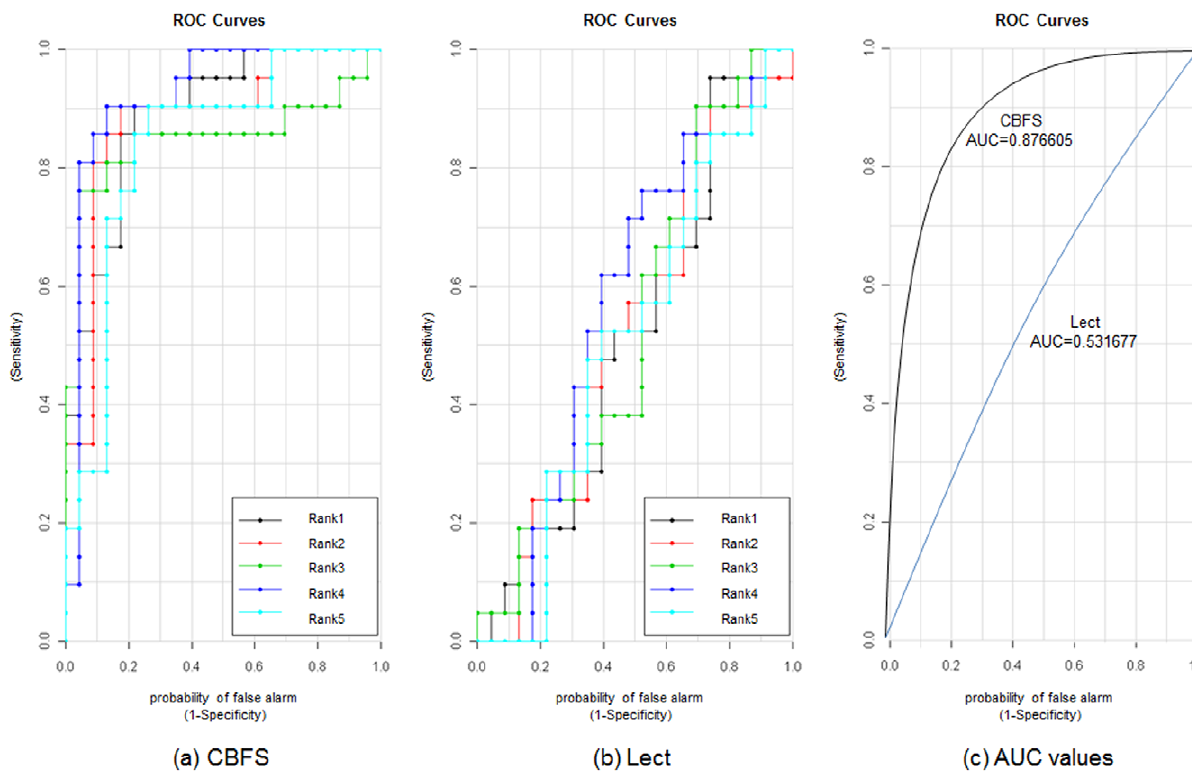
Figure 8. ROC curve and AUC values for CBFS and Lect feature selection algorithms on the Duke dataset. doi:10.1371/journal.pone.0040419.g008 PLoS ONE |